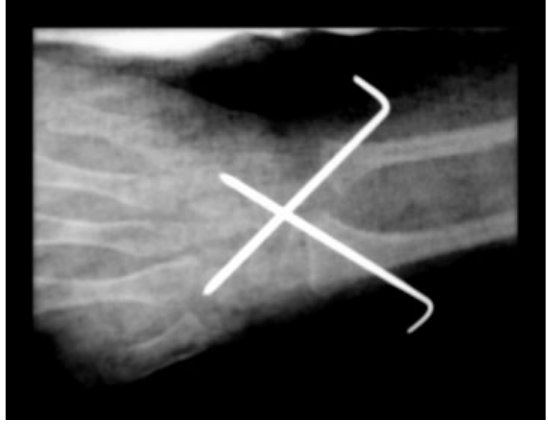
Fig. 3 X-ray with